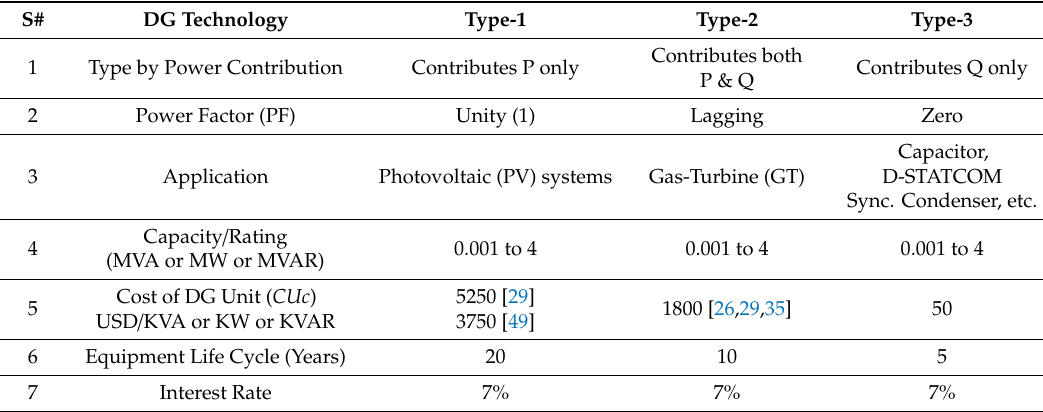
Table 3. DG types employed for evaluation for